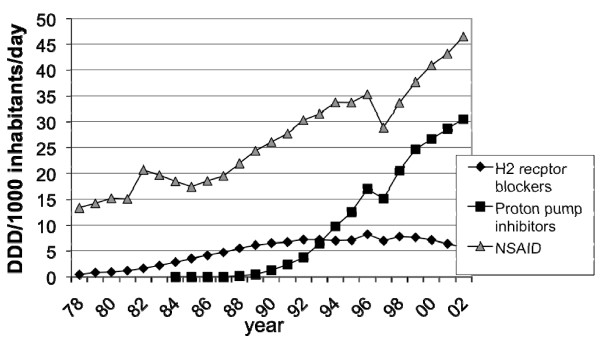
Sales of gastric acid inhibitors and NSAID:s in Sweden 1978–2002.